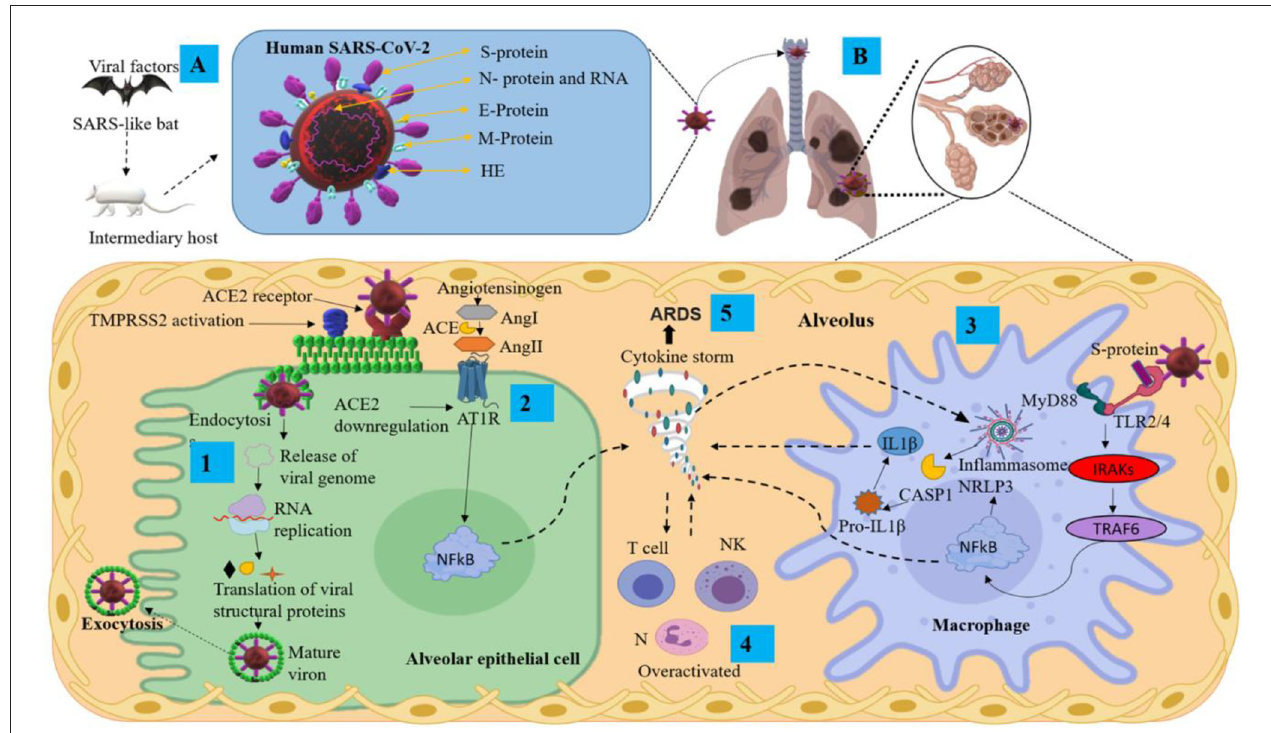
FIGURE 1 | Pathological mechanisms of SARS-CoV-2 in the pulmonary alveolus. (A) Mode of transmission and main structural proteins of SARS-CoV-2. (B) Mechanisms of SARS-CoV-2 infection and pulmonary inflammatory immune response. ACE2, angiotensin-converting enzyme 2; Ang, angiotensin; ARDS, acute respiratory distress syndrome; AT1R, angiotensin II type I receptor; CASP1, aaspase 1; E protein, envelope small membrane protein; HE, hemagglutinin esterase; IL1 β , interleukin 1 beta; IRAKs, interleukin-1 receptor-associated kinases; M protein, membrane protein; MyD88, myeloid differentiation primary response 88; N protein, nucleoprotein; N, neutrophils; NF- κ B, nuclear factor Kappa B; NK, natural killer cells; NLRP3, nucleotide-binding domain-, leucine-rich repeat-containing receptor, pyrin domain-containing 3; RNA, ribonucleic acid; S protein, spike protein; TMPRSS2, transmembrane serine protease 2; TRAF6, tumor necrosis factor receptor-associated factor